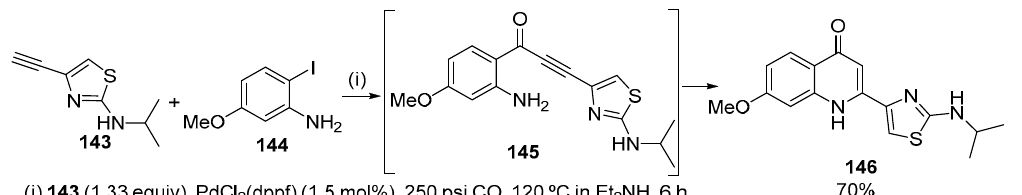
Molecules 2019 , 24 , 228 27 of 75 Scheme 43. Synthesis of 2,3-dihydroquinolin-4(1 H )-ones 137 via Sonogashira coupling of 2- (pseudo)haloanilines 135 with propargyl alcohols 131 followed by acid-catalysed tandem Rupe rearrangement-Donnelly-Farrell ring closure of anilines 136 [61]. The Pd-catalysed carbonylative coupling of 2-haloanilines 139 with terminal arylacetylenes 47 , initially reported by Torii and Kalinin [ 32,33 ] , appears to be the most versatile method for the synthesis of 2-substituted quinolin-4(1 H )-ones 141 . The desired compounds were obtained in good yields using either PdCl 2 (PPh 3 ) 2 or PdCl 2 (dppf) and an excess of Et 2 NH which acts as solvent and base and plays a key role in the cyclization step (Scheme 44). 2-Iodoanilines are preferred to 2- bromoanilines and react both as a free base and in the hydrochloride form although the latter in lower yield [62]. The reaction of arylacetylenes generally gave better yields than aliphatic acetylenes, which may be due to the acidity of the acetylene proton. Functional groups, such as thiophenyl, acetal, tetrahydropyran (THP), ester, keto and ether, tolerate the reaction conditions. When the nitrogen of the anilines has a substituent, decrease of the nucleophilicity retards the cyclization. In fact, reaction with alkylated aniline, under the same reaction conditions, led to the corresponding enamine 142 as main product (52%) and only 20% of quinolin-4(1 H )-one 141 was obtained, although subsequent treatment of the enamine with sodium hydride in THF led to quinolin-4(1 H )-one 141 quantitatively [32,33]. Decrease of CO pressure or temperature drops the reaction yield. Scheme 44. Synthesis of 2-substituted quinolin-4(1 H )-ones 141 by Pd-catalysed